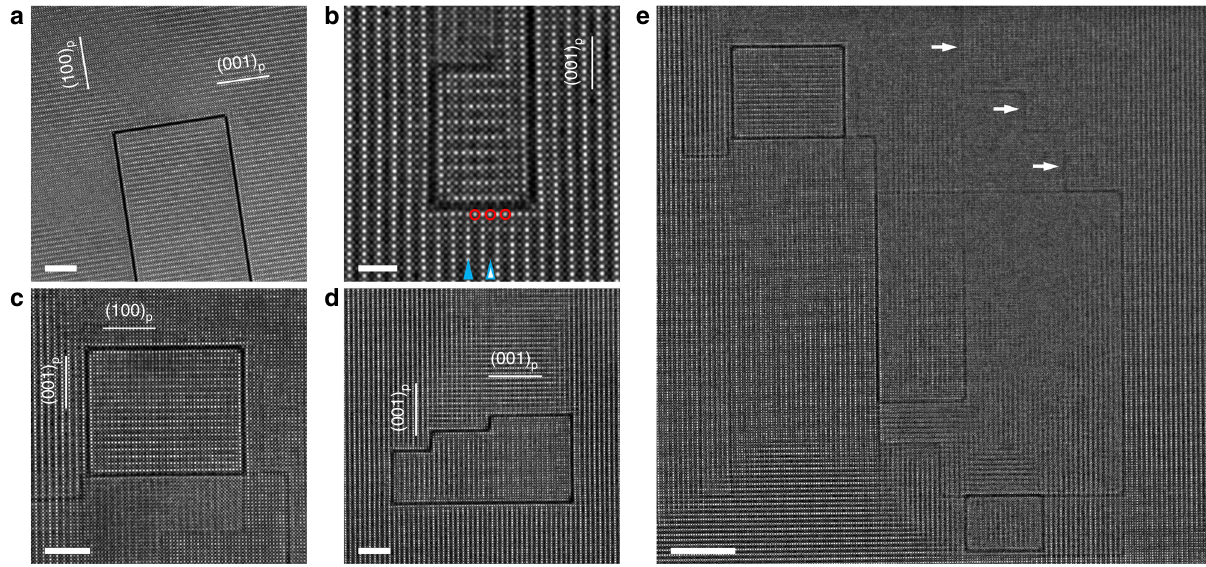
Fig. 1 Single-atom-layer traps (SALTs) in LLTO. a – d HAADF-STEM images of the 2D defects that formed SALTs. The LLTO planes parallel with the 2D defects are marked directly in images. A La-rich A-site layer and a La-poor one in LLTO were indicated by solid and empty arrows, respectively, in b . The red circles indicated three A-site atomic columns that were located in the La-poor layer of LLTO but became La-rich because of the neighboring 2D defect layer. e Ubiquitous presence of SALTs. The bright arrows indicated three 2D defects that appeared less dark due to the coexisting LLTO in their atomic planes. The scale bars in a , b , c , d and e are 5 nm, 2 nm, 5 nm, 5 nm and 10 nm,